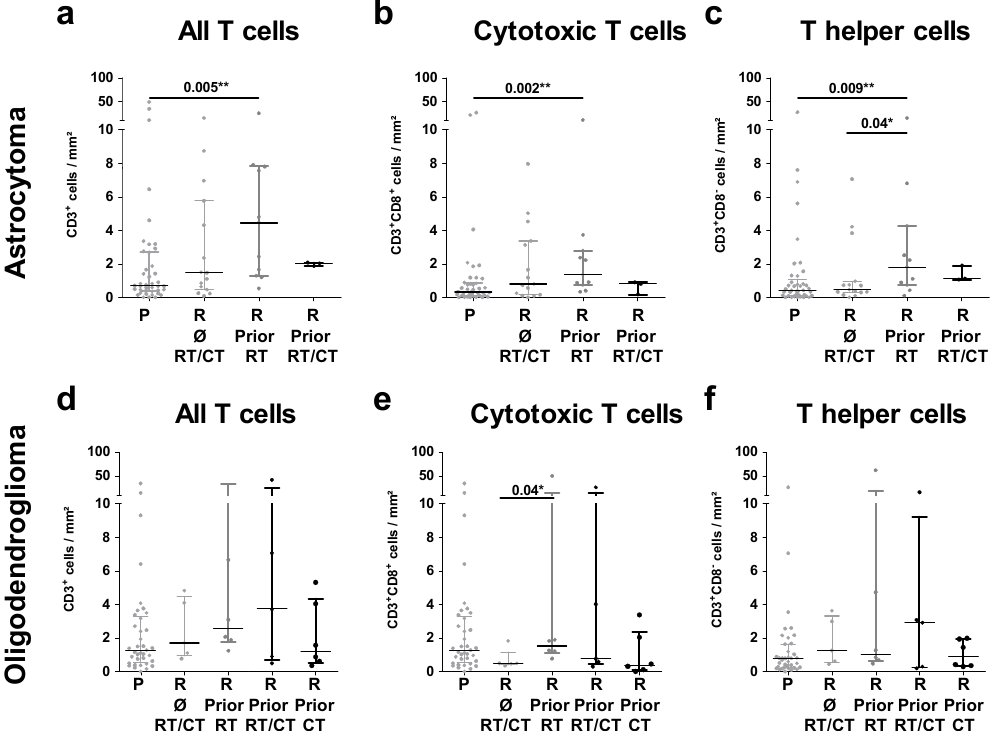
Figure 4. T-cell infiltration in primary and recurrent IDH mut gliomas according to pretreatment: primary and recurrent ( a – c ) astrocytoma and ( d – f ) oligodendroglioma were classified according to the previous treatment of their predecessor tumor. Infiltration rates of ( a , d ) all T cells, ( b , e ) cytotoxic T cells, and ( c , f ) T helper cells were analyzed. P, primary; R, recurrent; Ø, no prior; RT, radiotherapy; CT, chemotherapy; RT/CT, radiochemotherapy; and mm 2 , square millimeter; * p < 0.05; and ** p < 0.01.